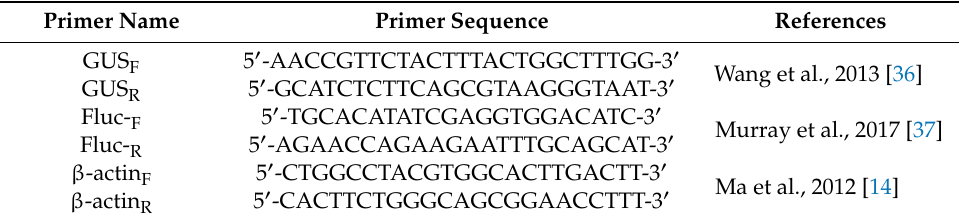
Table 1. Primers used for